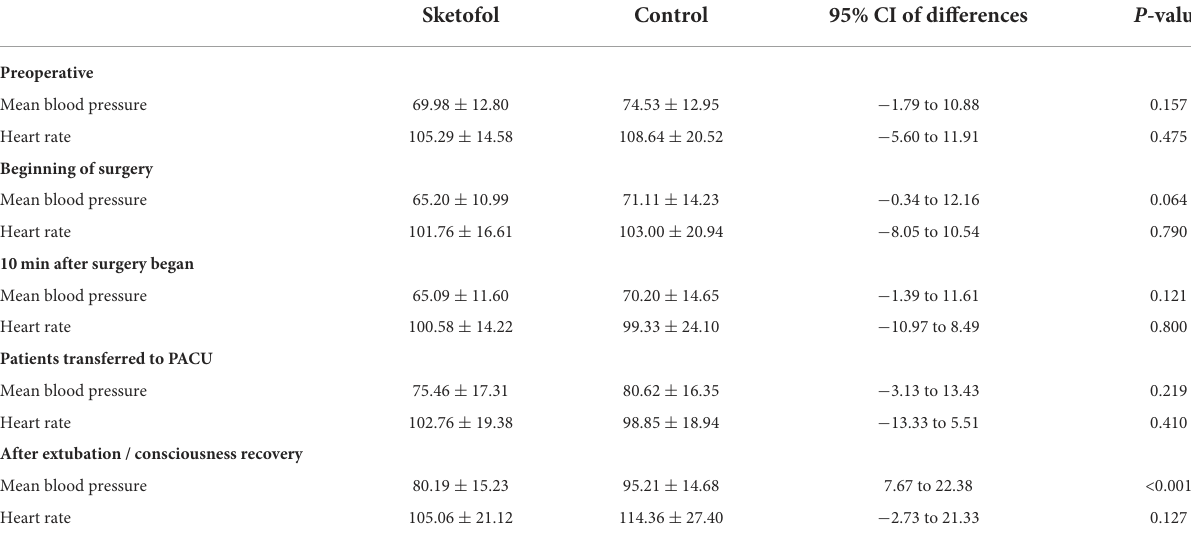
TABLE 4 Mean blood pressures and heart rates at different time-points. Sketofol Control 95% CI of differences P -value